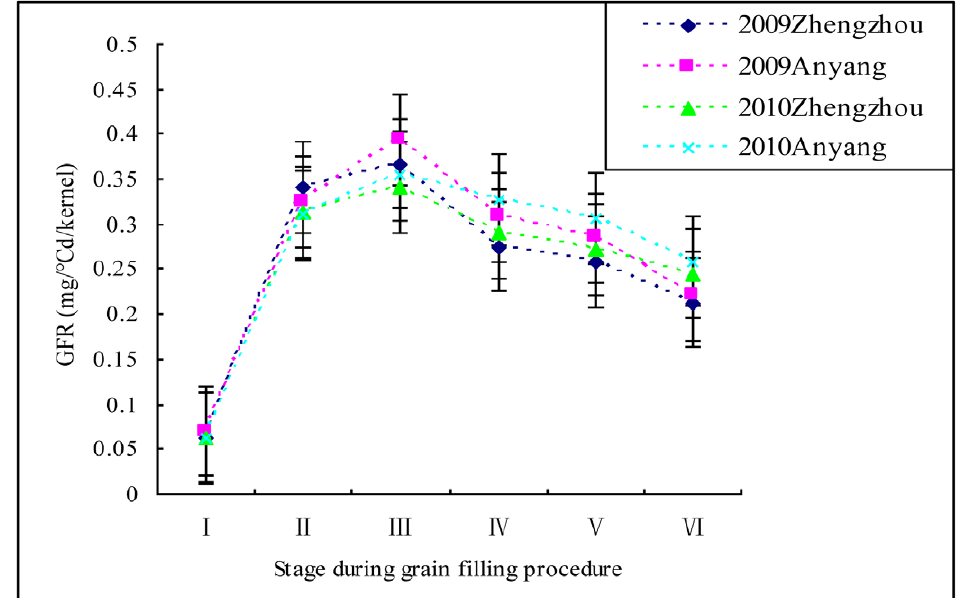
Figure 2. Dynamic diversity of grain filling rates in maize strains. doi:10.1371/journal.pone.0056344.g002 PLOS ONE |